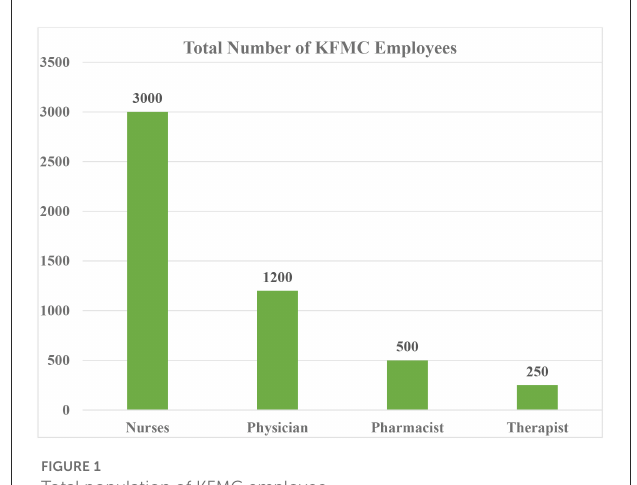
FIGURE1 Total population of KFMC